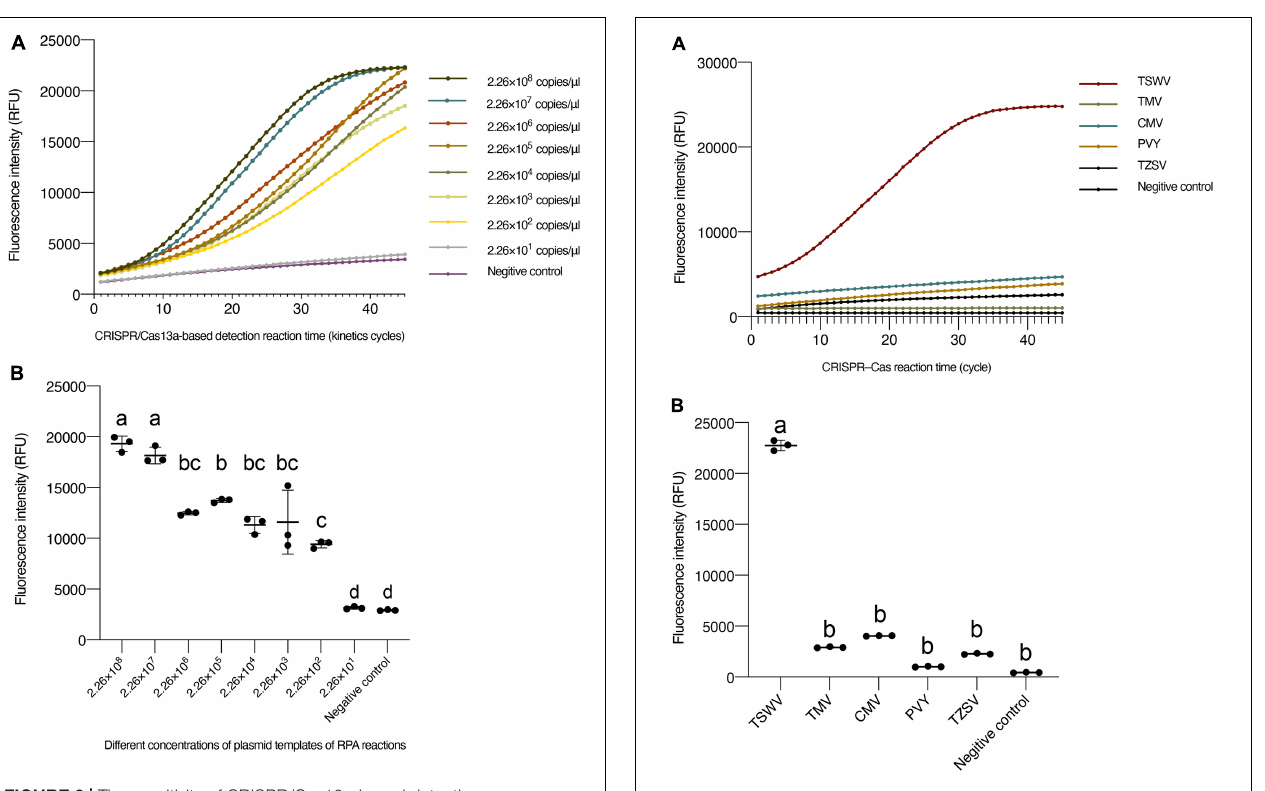
FIGURE 4 | The specificity of CRISPR/Cas13a-based detection for the TSWV. (A) Fluorescence intensity for different viruses. (B) Intensity of fluorescence signals generated after 15 min (30 kinetics cycles) of CRISPR/Cas13a-based detection for different viruses. Negative control has RNase-free water as input instead of RPA production. Data are the mean ± SD from triplicate biological replicates measurements. Comparisons between groups were performed using an analysis of variance (ANOVA) followed by a Tukey’s test. Different letters above the error bars indicate significant differences at the 0.05 level. RPA, recombinant polymerase amplification; SD, standard deviation; TSWV, tomato spotted wilt